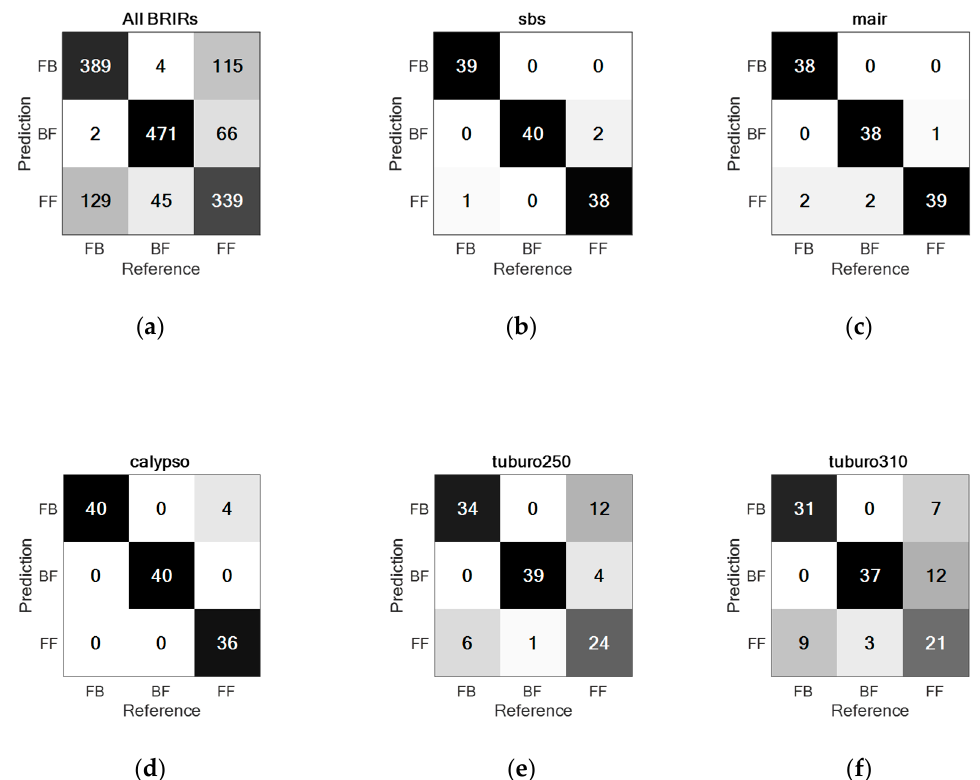
Figure 3. Confusion matrices obtained for the models trained and tested using recordings synthesized with selected sets of BRIRs: ( a ) all BRIR sets; ( b ) sbs; ( c ) mair; ( d ) calypso; ( e ) tuburo250; and ( f ) tuburo310.